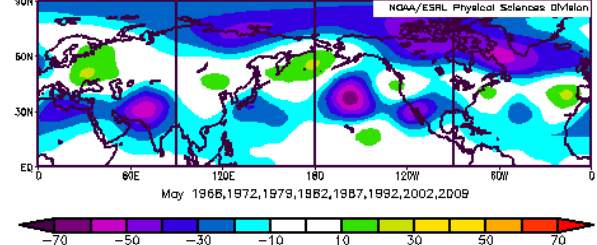
Figure 4. Composites of global northern hemispheric 200hPa geopotential height anomalies for the month of May for selected (a) warm and (b) cold air